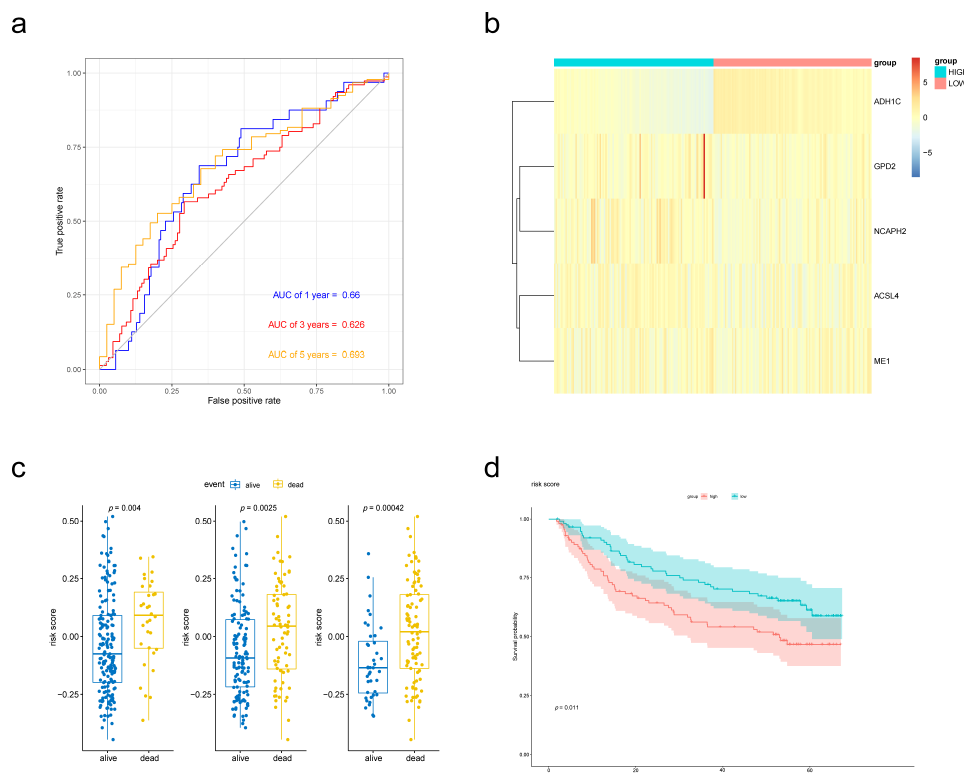
Figure 5. External validation of the prognostic performance of the five-gene signature in GSE14520 dataset. ( a ) Time-dependent ROC curve of risk score model for 1-, 3- and 5-year overall survival predictions. ( b ) Heat map of the five-gene expression in GSE14520 cohort. ( c ) Boxplot of risk scores for different states. ( d ) Kaplan–Meier survival curves of the risk score model.